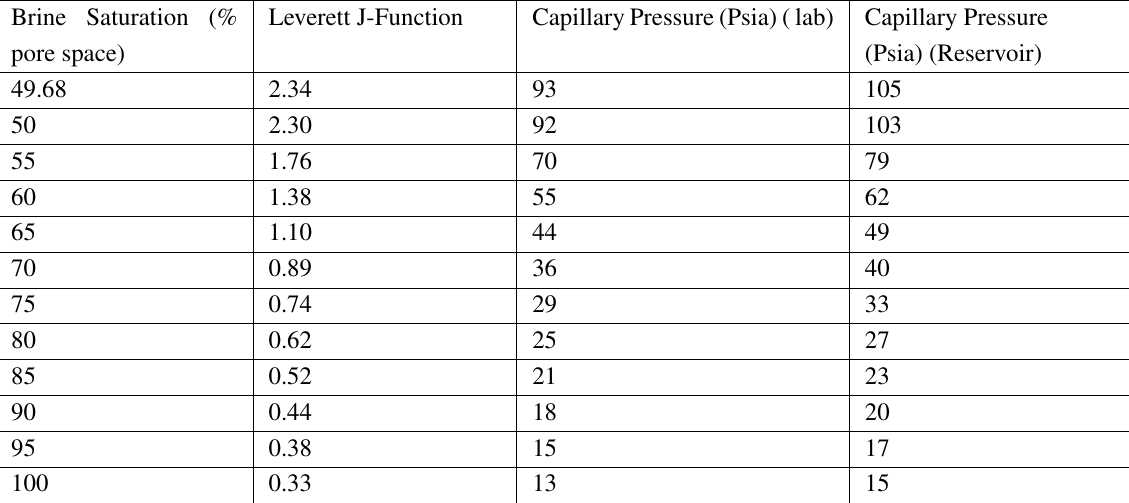
Table 5. Capillary Pressure calculation for Upper Bahariya